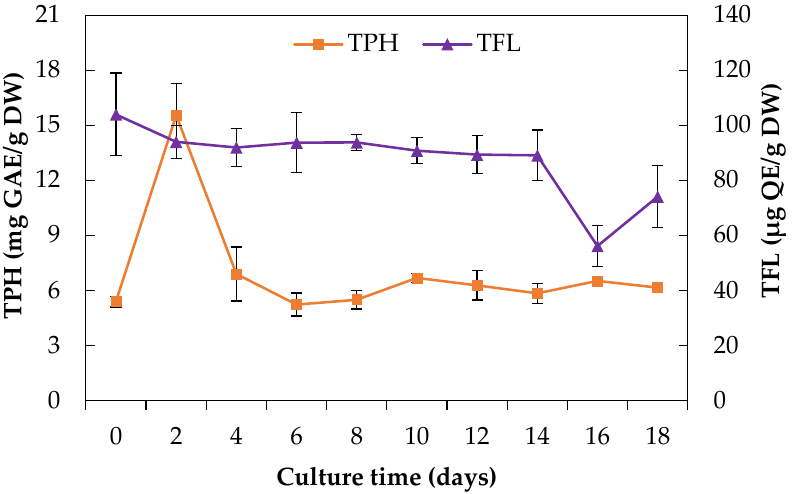
Figure 3. Production of total phenolics (TPH) and total flavonoids content (TFL) of a cell suspension culture of Eysenhardtia platycarpa over 18 days of culture. Values represent the mean ± standard deviation of three replicates.